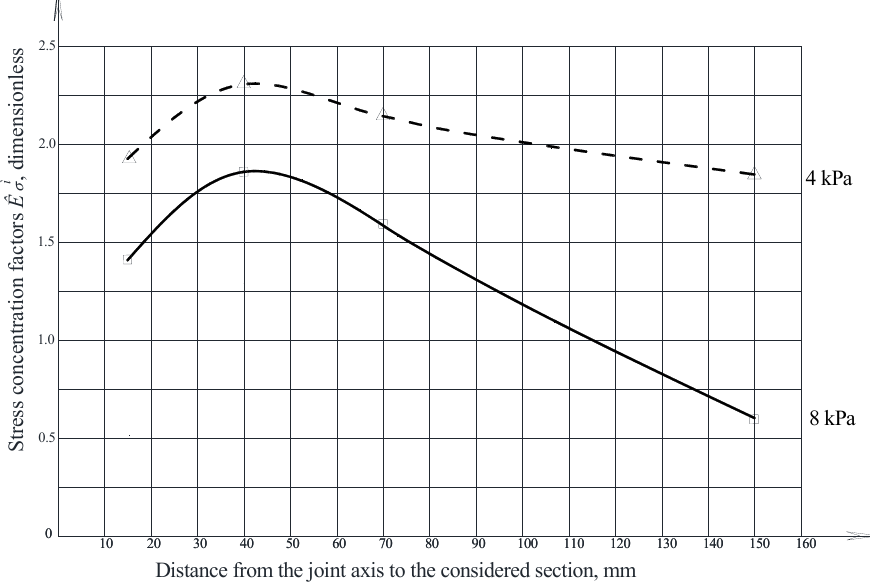
Figure 10. The meridional stress concentration in the field joint zone of the wall with a bend of 30 mm in section C-3.